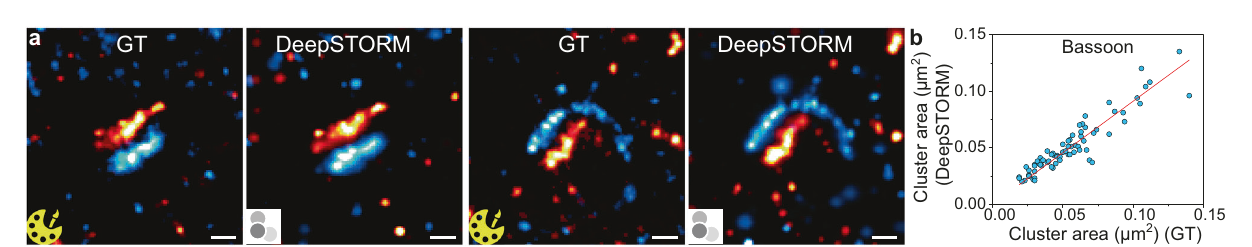
Fig. 4 | Resolving synaptic active zone nanostructures Bassoon and Homer using DeepSTORM. a Comparison of two images of presynaptic Bassoon (cyan) and postsynaptic Homer (red) scaffold proteins in the active zone of neurons betweengroundtruth(GT;0.5nM,10,000frames,25min;yellowPicassoicon)and predicted images (5nM, 800 frames; 2min; DeepSTORM icon). b The cluster area